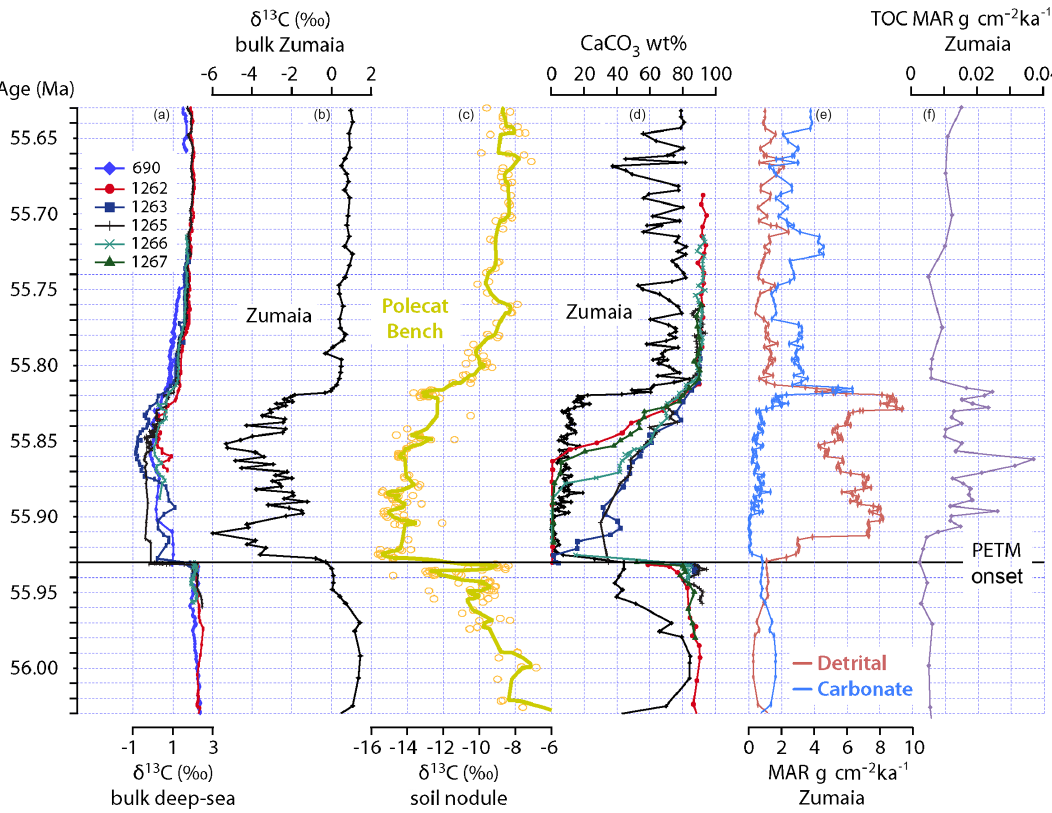
Figure 6. Comparison of the Zumaia records against terrestrial (Big Horn Basin) and deep-ocean sites (Walvis Ridge ODP Sites 1262, 1263, 1265, 1266, 1267; Maud Rise ODP Site 690) in the same cyclostratigraphic age model: (a) bulk carbonate δ 13 C for deep-ocean sites; (b) bulk carbonate δ 13 C for Zumaia; (c) soil nodule δ 13 C from the Big Horn Basin; (d) CaCO 3 records from Zumaia and the deep-ocean sites; (e) detrital (red) and CaCO 3 (blue) MARs from Zumaia; (f) organic carbon MAR from